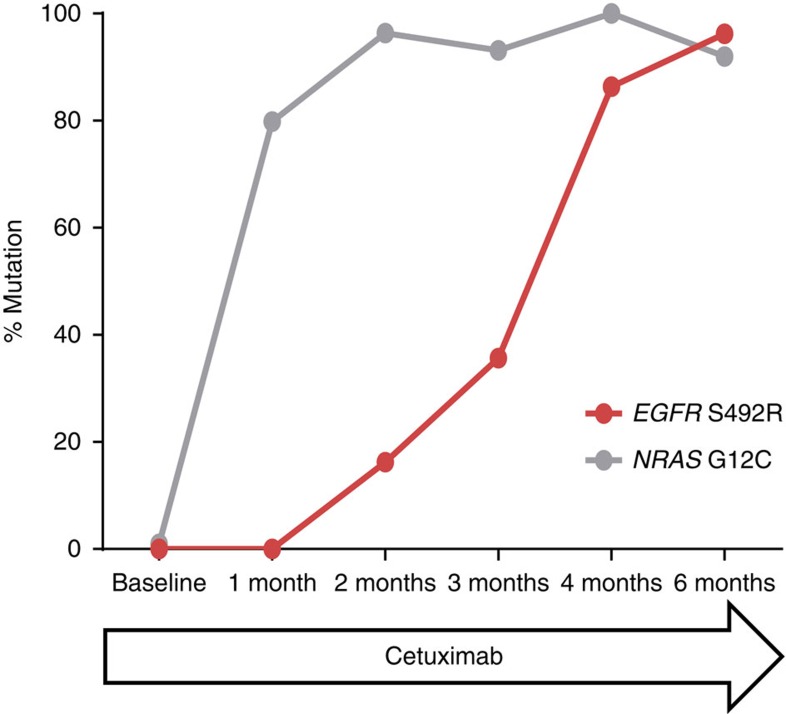
Selection of RAS and EGFR ECD mutations during development of resistance to EGFR blockade in CRC cells.Mutational profiles were used to monitor clonal dynamics of LIM1215 CRC cells under cetuximab treatment. Frequency of the NRAS G12C and EGFR S492R mutations at each time point are shown as determined by NGS. The frequencies presented were adjusted for gene copy number as it was determined by FISH analysis that LIM1215 has a duplication of the EGFR locus (7p.11.2) in the p-arm of chromosome 7 (Supplementary Fig. 5).